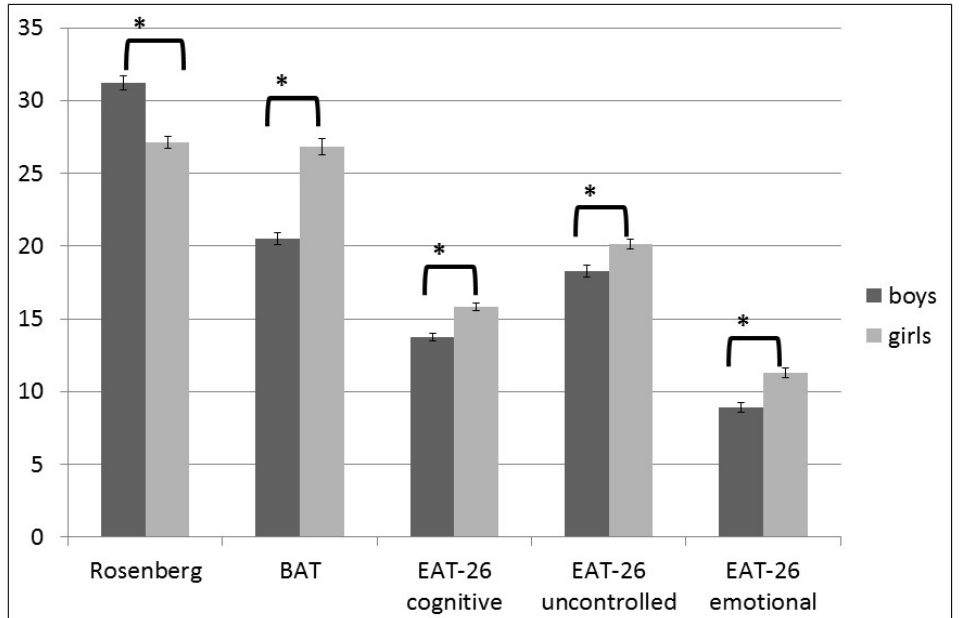
Figure 2. Our results showed significant differences in gender on the psychological tests (data are shown as mean ± S.E.M, * = p < 0.001). (Rosenberg = Rosenberg Self-esteem Scale; BAT = Body Attitude Test; EAT-26 = Eating Attitudes test: cogni- tive restraint, uncontrolled eating, emotional